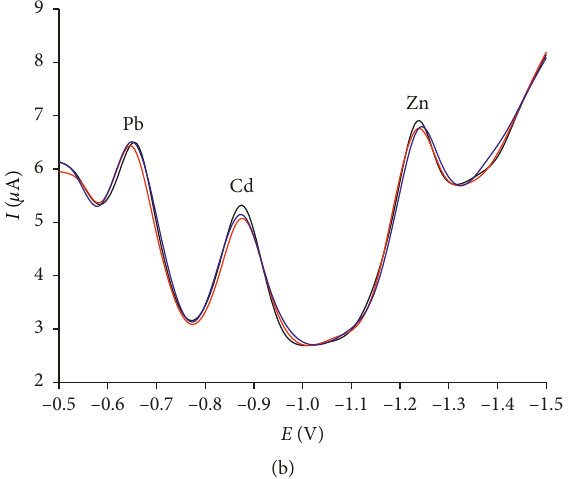
Figure 1: Profiles for predicated values (a) and reliability function for peak current of Pb (b).